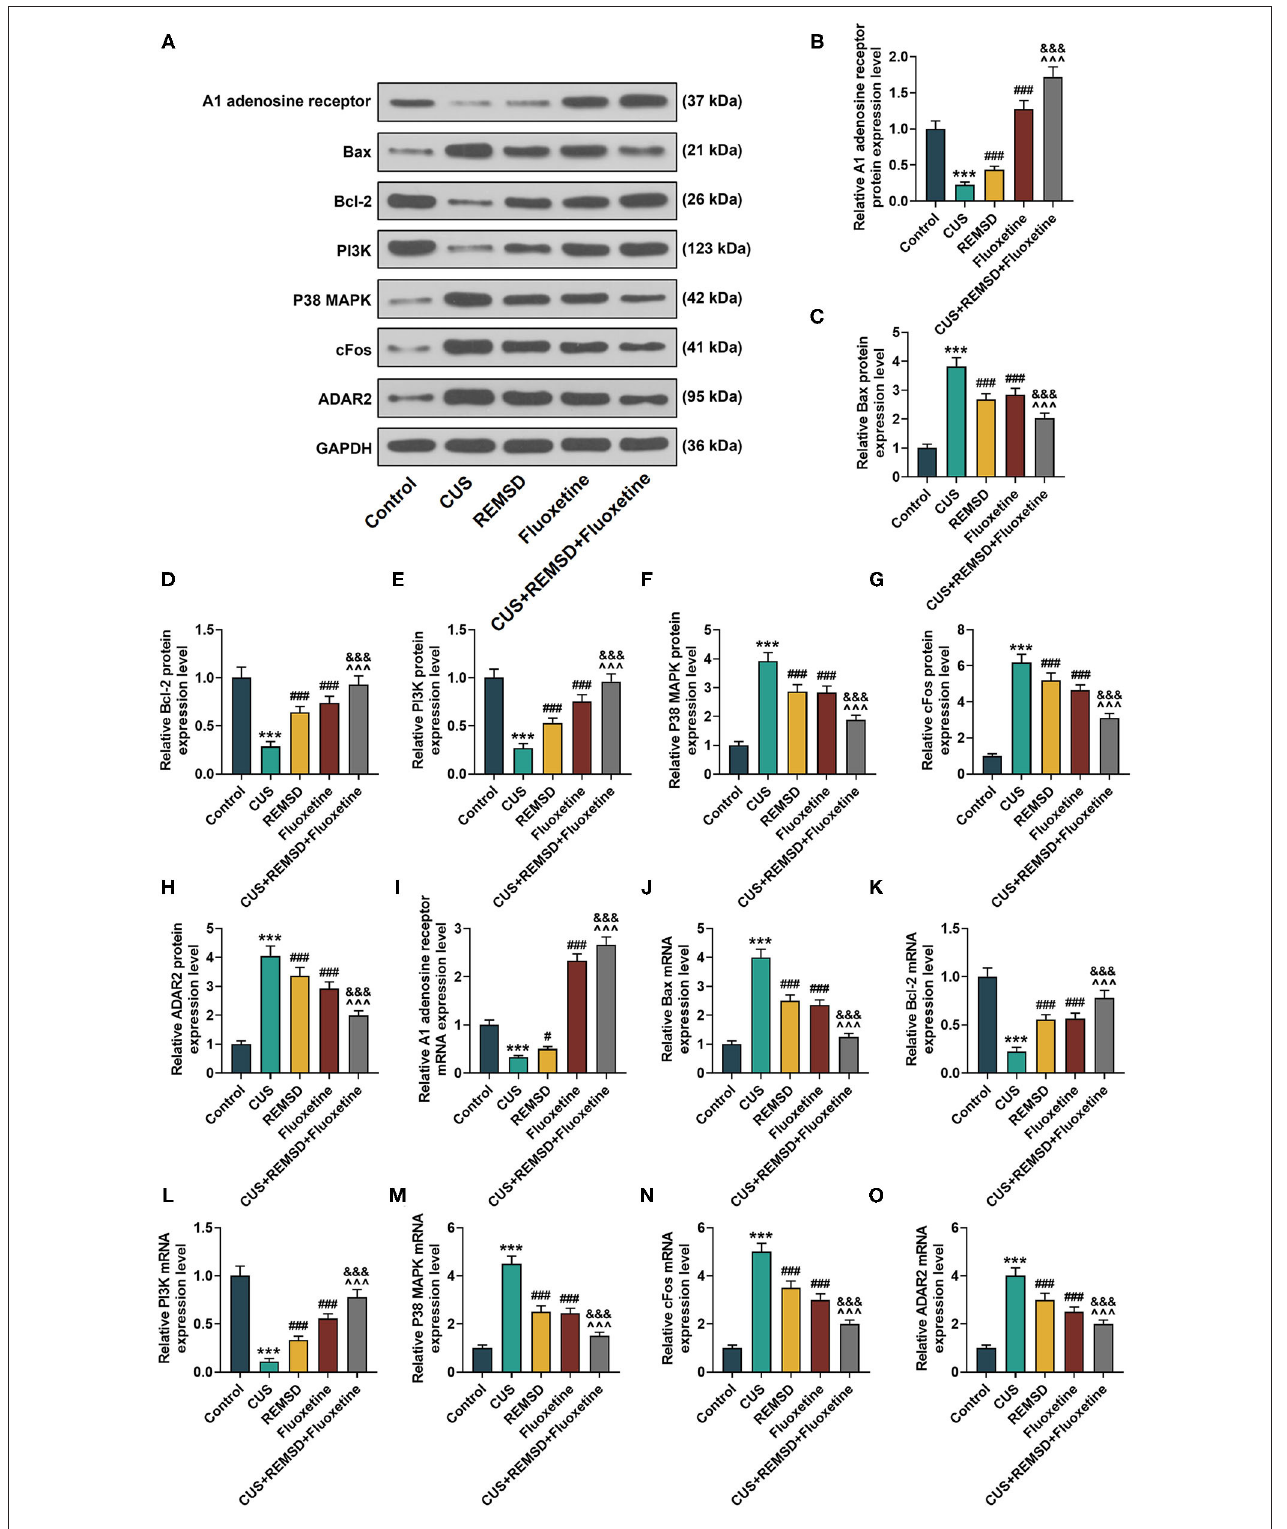
FIGURE 3 | REMSD combined with fluoxetine had regulatory effects on expressions of A1 adenosine receptor, apoptosis- and PI3K/P38 MAPK axis-related proteins, cFos, and ADAR2 in hippocampi of rats with depression. (A–H) Relative protein/GAPDH expressions of A1 adenosine receptor, apoptosis- and PI3K/P38